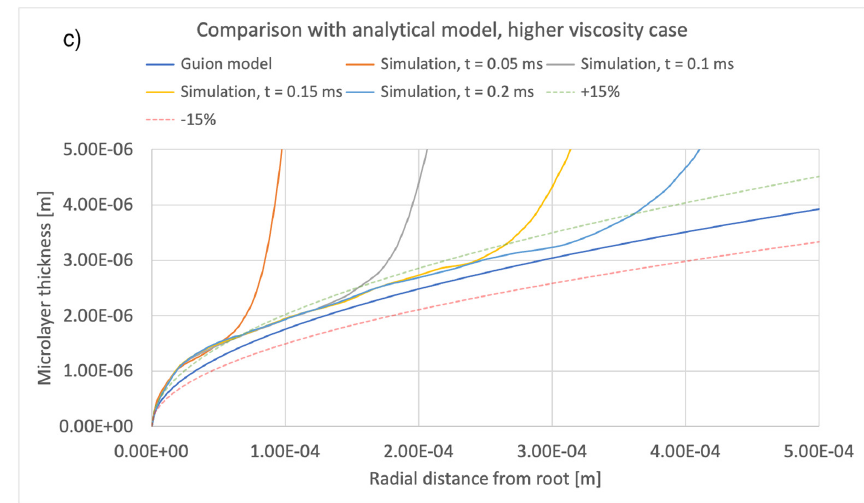
Figure 15. Comparison of current simulation results with the model of [12] ; effect of liquid viscosity. Radial distributions of microlayer thickness at a sequence of times into bubble growth are compared with predictions of the model of [12] . Panels ( a – c ) show microlayer profiles for different values of the liquid viscosity.